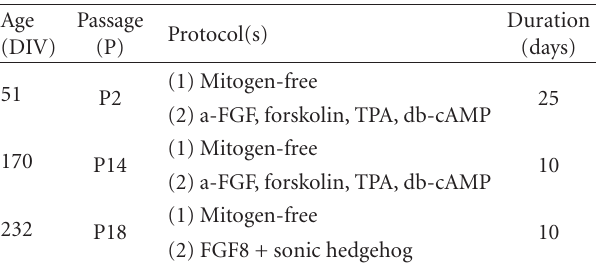
Table 1: Di ff erentiation of long-term propagated neural tissue- spheres (NTS) derived from the embryonic porcine ventral mesen- cephalon